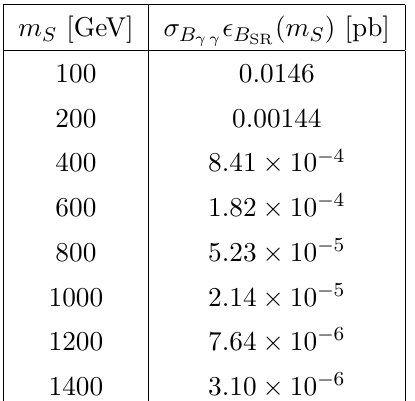
Table 6 . The background cross section times e(cid:14)ciency (cid:27) B signal region. For this signal region the e(cid:14)ciency is independent of m t 0